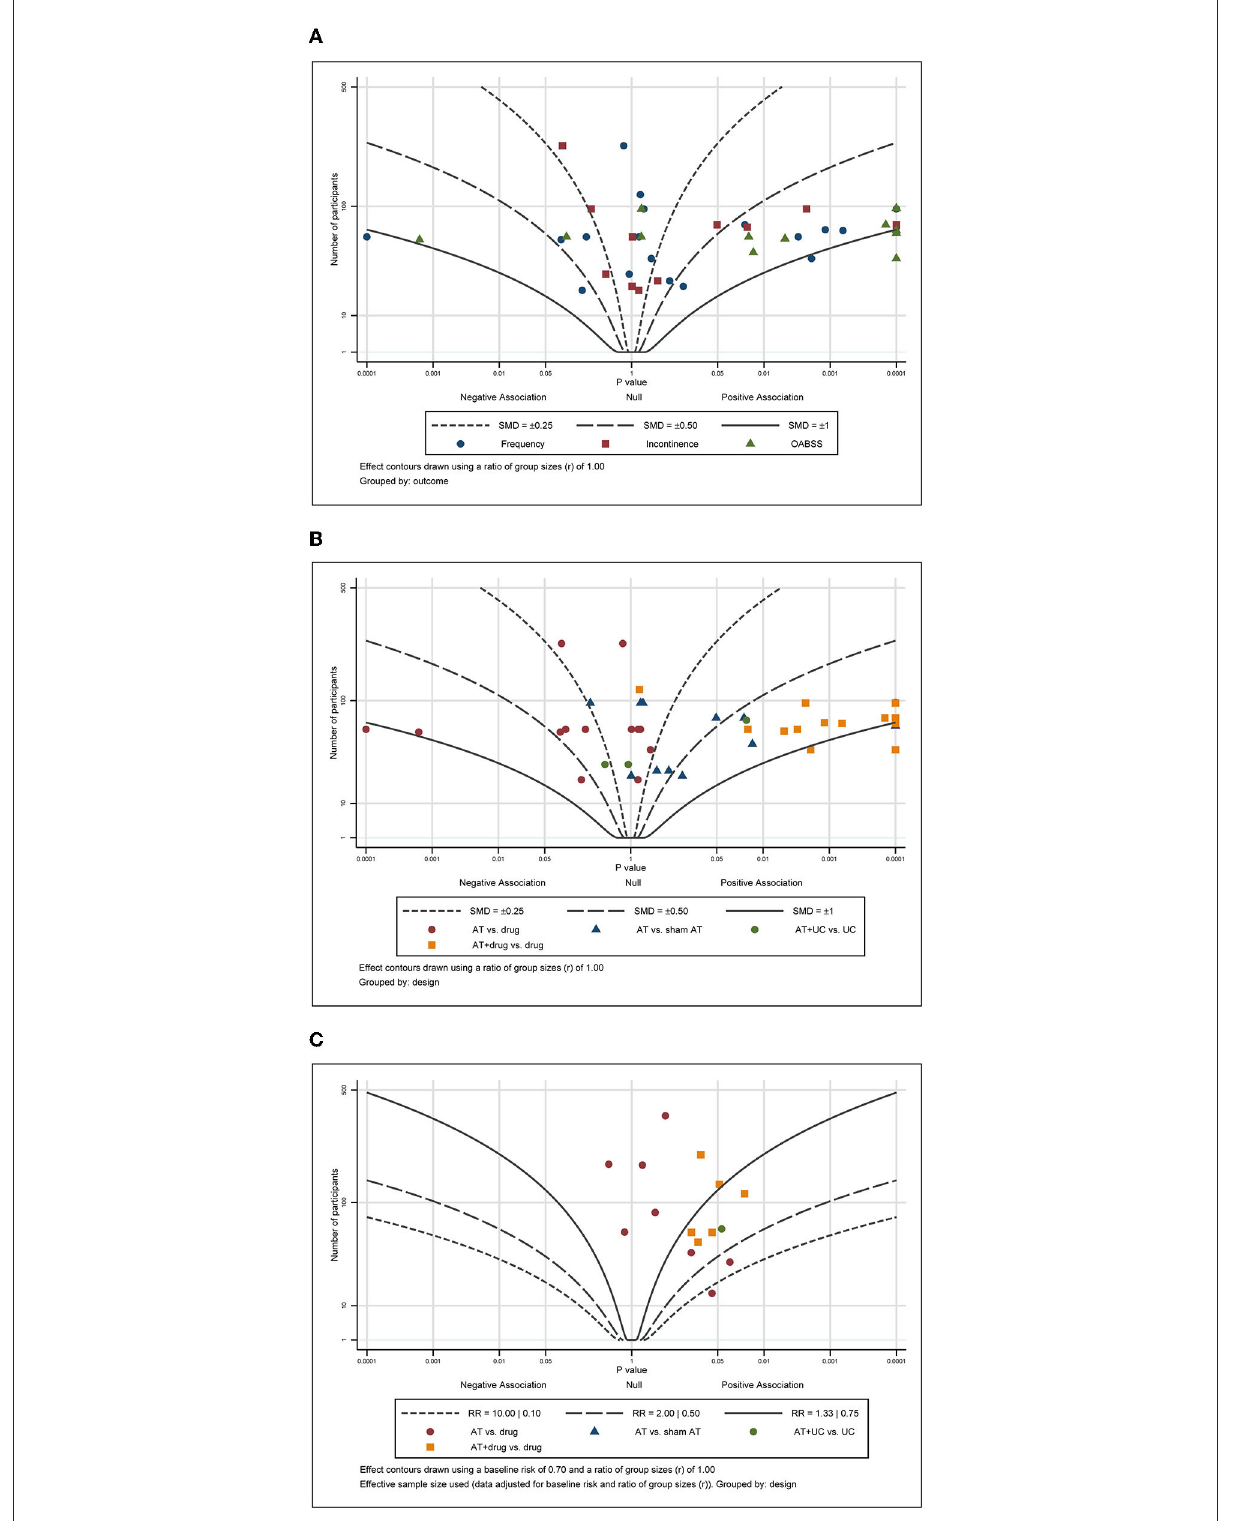
FIGURE6 Albatross plot of (A) frequency, (B) incontinence, and (C) response rate according to the comparison of MA plus standard care vs. standard